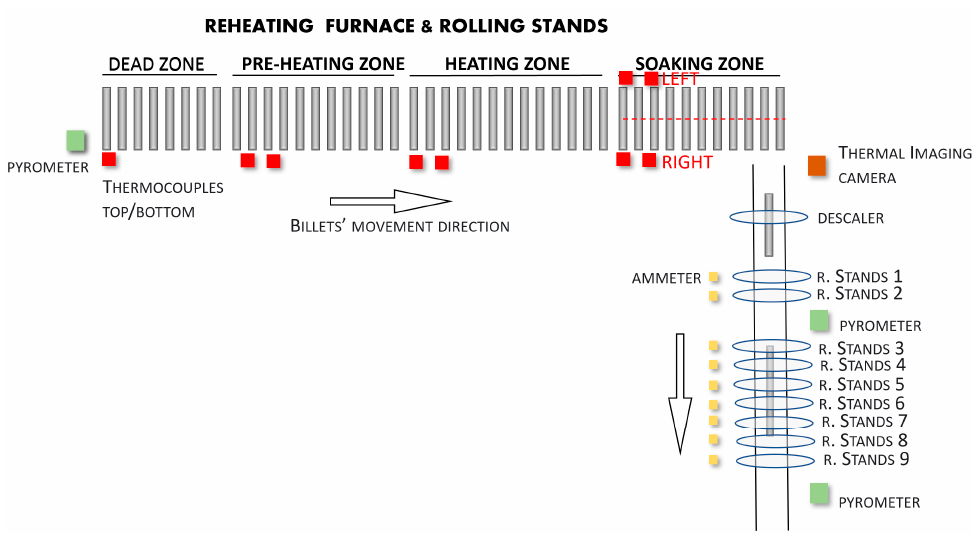
Figure 3. Original configuration of the plant. Table 1. Furnace zone